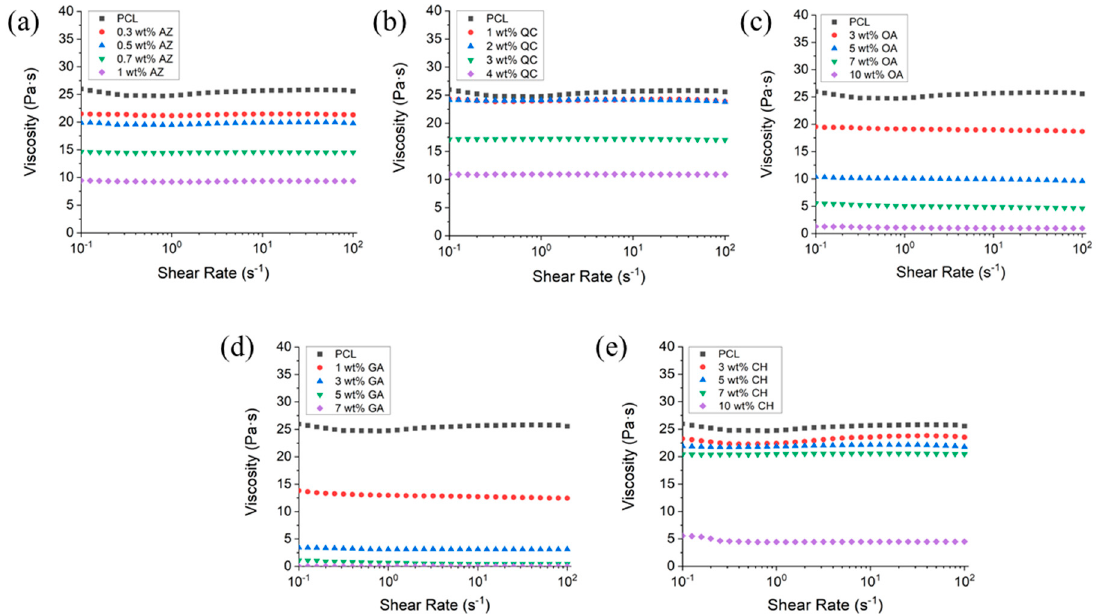
Figure 6. Effect of amount and type of additive introduced into PCL on viscosity at 200 °C: ( a ) AZ, ( b ) QC, ( c ) OA, ( d ) GA, ( e ) CH.